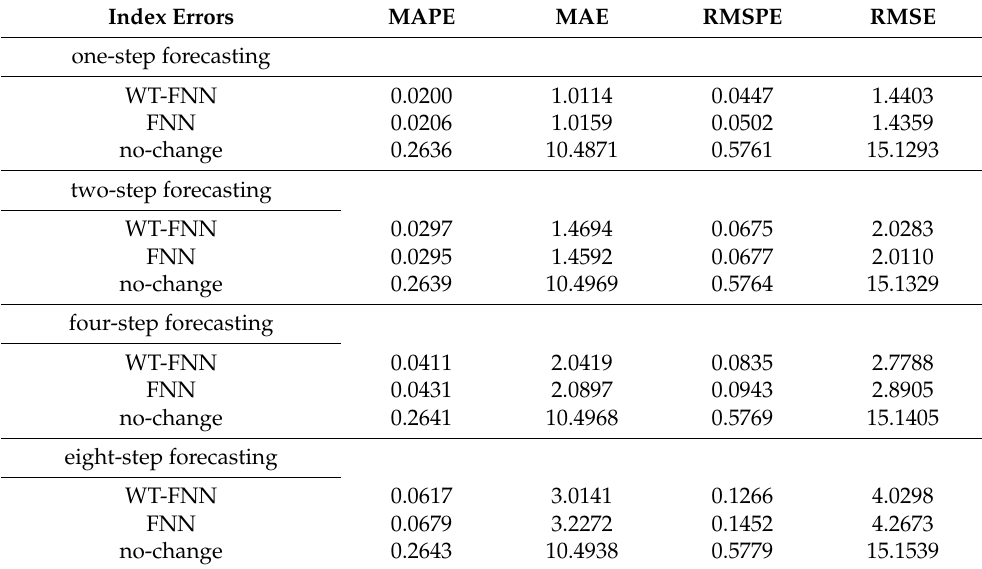
Table 6. Comparisons of predictions from different forecasting models with different forecasting window sizes.